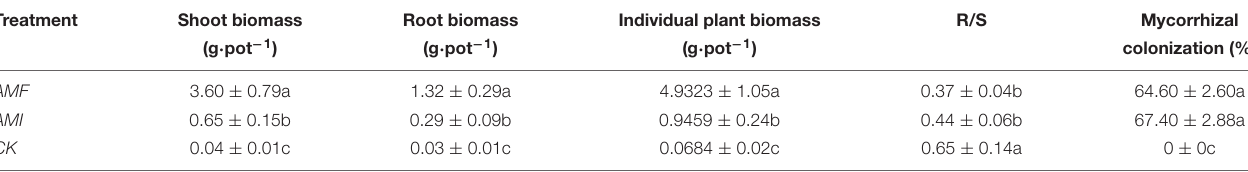
TABLE 1 | Plant biomass, root/shoot ratio, and mycorrhizal colonization of B. tripartita under different treatments. Treatment Shoot biomass Root